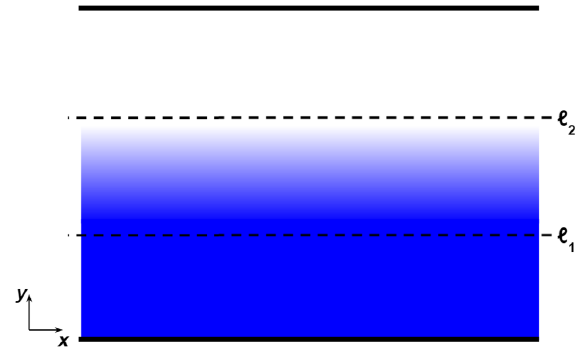
FIG. 6. Charge transport per measurement cycle in the Zeno limit. The analytic formula given in Eq. (30) is compared with the transport found from direct simulation for a selection of hopping probabilities.